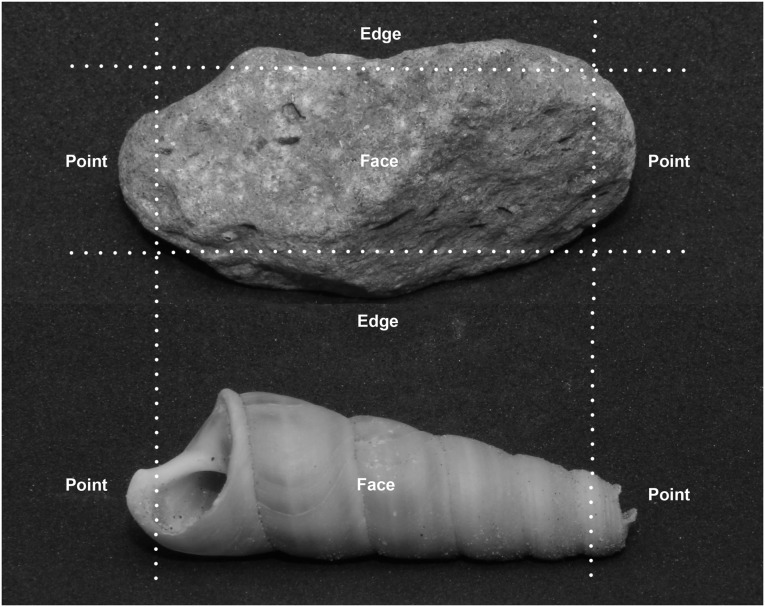
Photographs of stone and shell tools with tool surfaces labeled: P—points, E—Edges, and F—faces.The use of shell tools was scored as either point or face only.